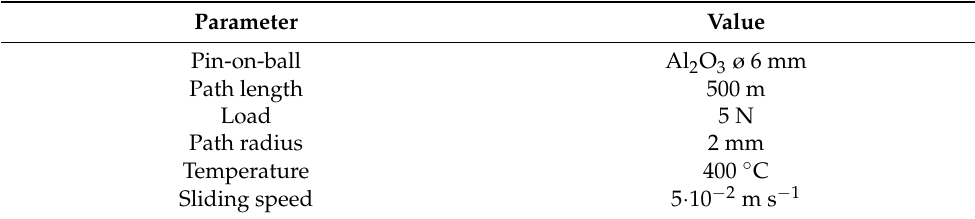
Table 2. Parameters of Pin-on-Disc Test at the temperature of 400 ◦